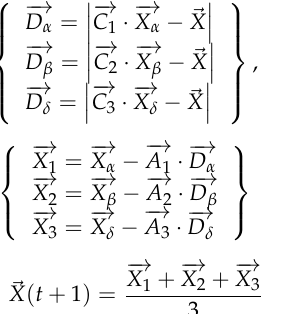
Fig. 6 represent the structure of RBFNN, in